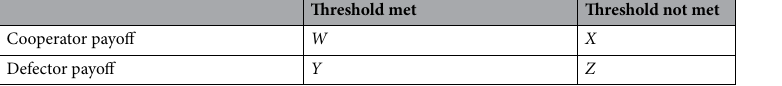
Table 1. The payoffs that Cooperators and Defectors receive in the threshold PGG depending on whether or not the minimum threshold number of Cooperators ( τ ) is met. Payoff parameters are subject to constraints: X < Z , Z < W , Z < Y .